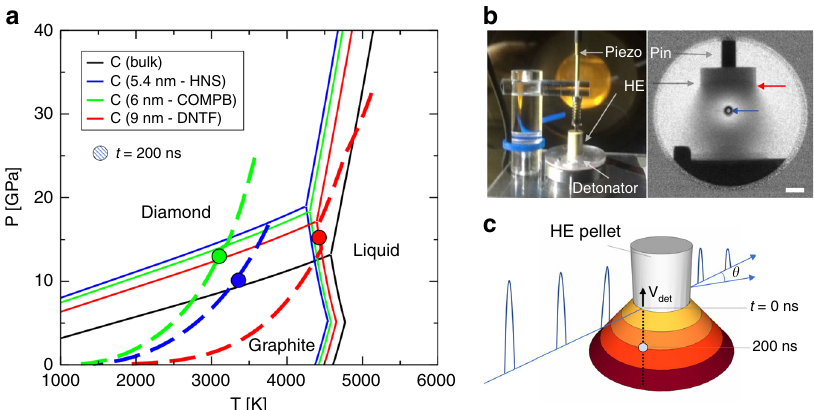
Fig. 1 Carbon phase diagram and TR-SAXS method. a Adiabats for HNS, Comp B, and DNTF (blue, green, and red dashed lines, respectively) calculated using thermochemical modeling. Solid circles along these adiabats identify the calculated position for the detonation products at t = 200 ns post- detonation. These data are superimposed on the computed carbon phase diagram with explicit consideration for particle size, calculated for sizes of 5.4 nm, 6 nm, 9 nm, and bulk. Phase boundaries for these sizes are delineated by blue, green, red, and black solid lines, respectively. Diamond forms at pressures and temperatures in the upper left, metastable graphite at the lower left, and liquid at the far right. In the high explosive DNTF, ~200 ns marks a phase transition between liquid and solid graphitic carbon products. b A small-scale detonation assembly typical for synchrotron, time-resolved small-angle X-ray scattering experiments and dynamic scatter-beam imaging during detonation. Note the curved detonation front (red arrow) at the interface between the undetonated HE (e.g., HNS shown) and the denotation products, which include carbon condensates; also, the relative position of the X-ray beam is apparent from the location of the primary beam stop (blue arrow). Scale bar is 2 mm. c Schematic snapshot of the denotation front propagating with velocity, V det , along the axis of the pellet subsequent to initiation at the base of the pellet. The interface between the detonation front and the HE, at the elevation of the coincident X-ray beam (blue arrow), is de fi ned as t = 0 ns. The evolution of detonation products occurs over several hundred nanoseconds